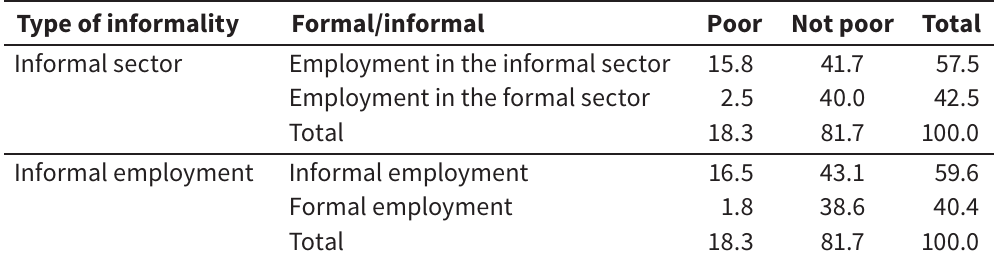
Workers by informality type and poverty Type of informality Formal/informal Informal